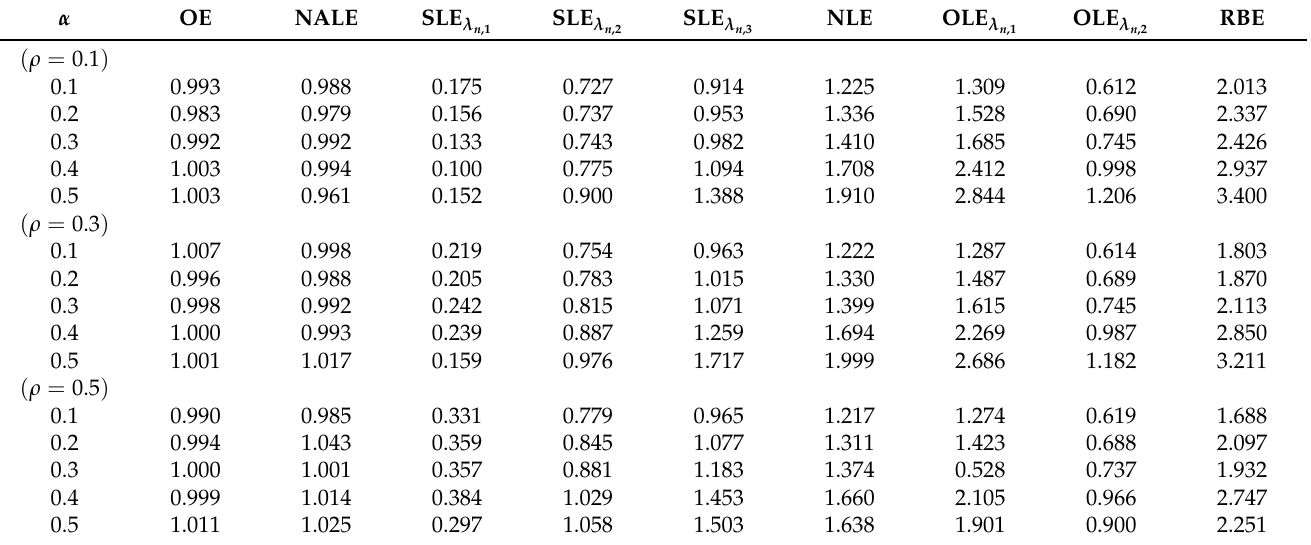
Table 2. Average RE of various estimators, true σ 2 =